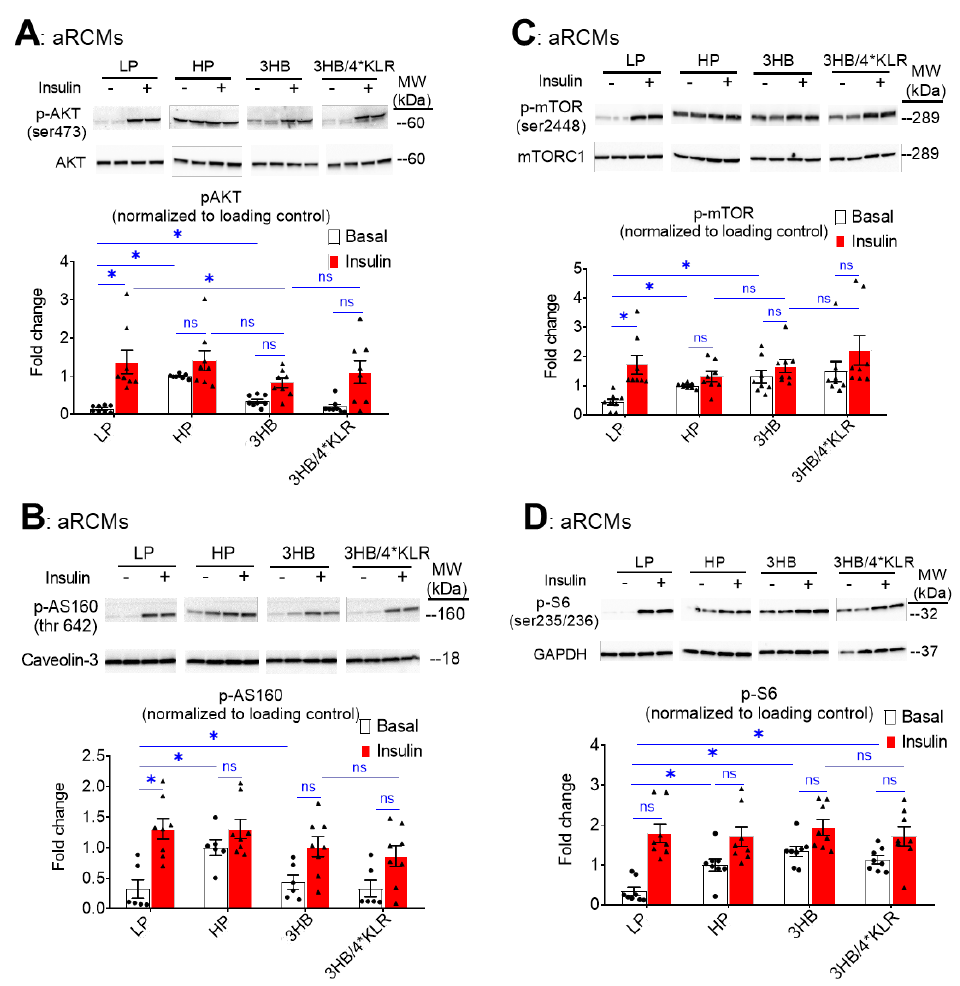
Figure 3. Chronic 3HB exposure interferes with insulin signaling in cardiomyocytes. ARCMs were cultured for 24 h in either low palmitate medium (LP; control condition), high palmitate medium (HP), LP with 3 mM 3HB (3HB), or LP with 3HB in the presence of 4*KLR (3HB/4*KLR). ( A , B ) After 24 h, cells were short-term (30 min) incubated without/with 100 nM insulin. Thereafter, ( A ) Ser473 phosphorylation of Akt, ( B ) Ser2447 phosphorylation of mTOR, ( C ) Thr 642 phosphorylation of AS160, and ( D ) Ser235/236 phosphorylation of S6 were assessed by Western blotting and quantified. For this, normalization was performed against loading controls. Loading control for the degree of phosphorylation of Akt and AS160 is caveolin-3. Loading control for mTOR and S6 phosphorylation is GAPDHs. Representative blots and corresponding loading controls are displayed (n = 8). Bar values are means ± SEM. * p < 0.05. ns: not significant. The dots represent the measurements that are performed under ‘basal’ condition. The triangles represent the measurements that are performed after insulin stimulation.